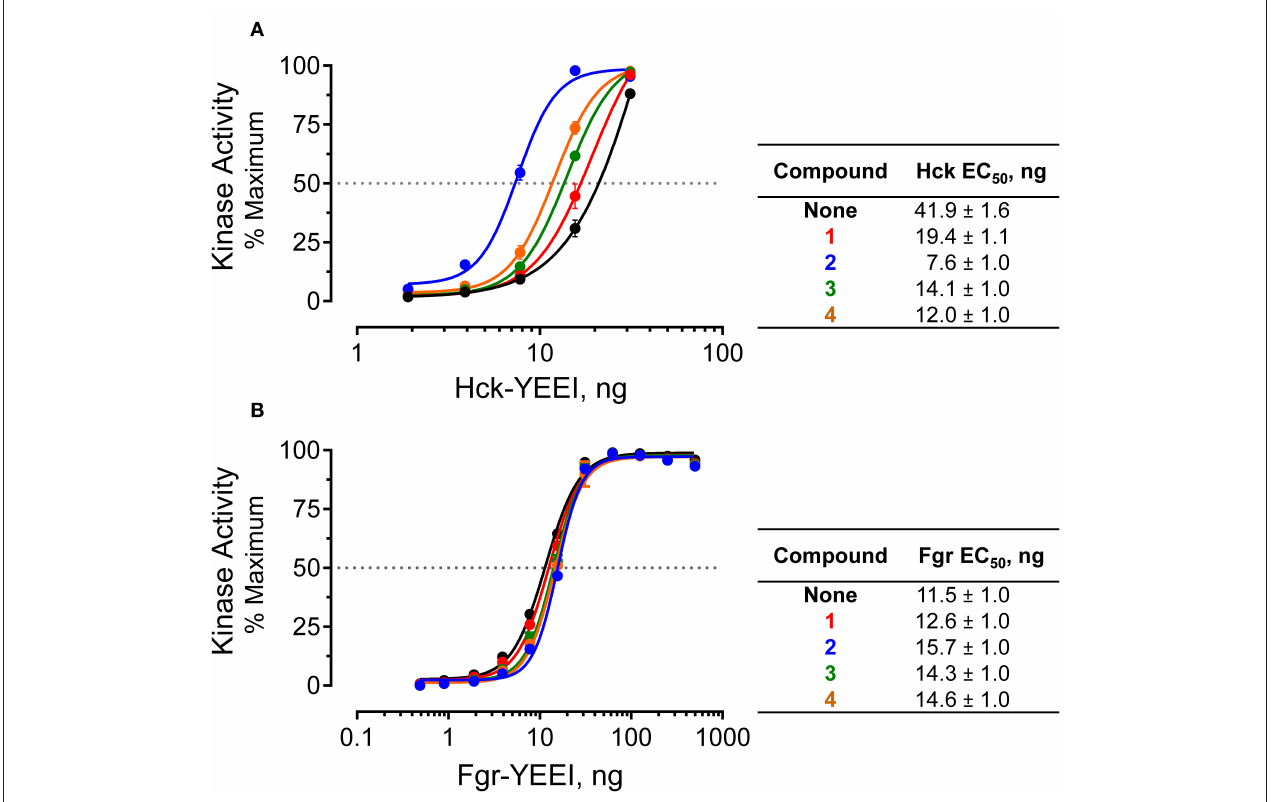
FIGURE 7 | Selective activation of near-full-length Hck by allosteric modulators in vitro . Recombinant, near-full-length Hck (A) and Fgr (B) were assayed for kinase activity using the Z’Lyte kinase assay over the range of input kinase protein amounts shown. Assays were performed in the absence (None) or the presence of each of hit compound ( 1 through 4 at a final concentration of 50 µ M). Each data point was assayed in quadruplicate, and is shown as percent of maximum substrate peptide phosphorylation ± SD. The activation curves were fit by non-linear regression analysis, and the resulting EC 50 values ± S.E. are summarized in the tables at